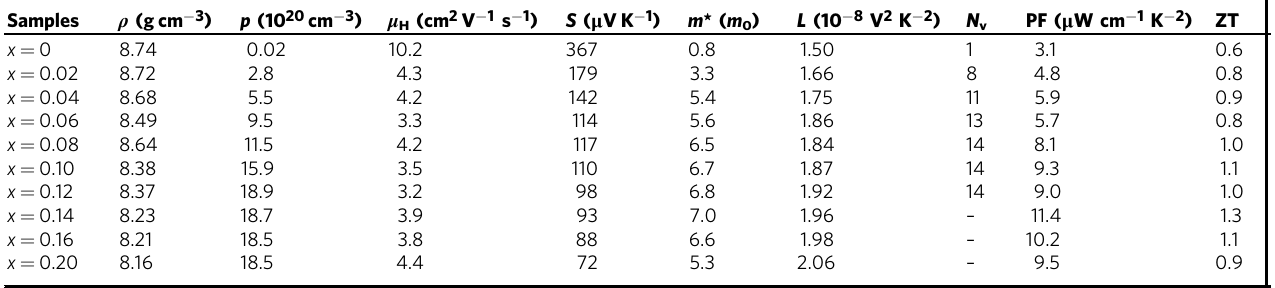
Table 1 Related physical properties of Bi 1 − x Pb x CuSeO ( x = 0 – 0.2) Samples